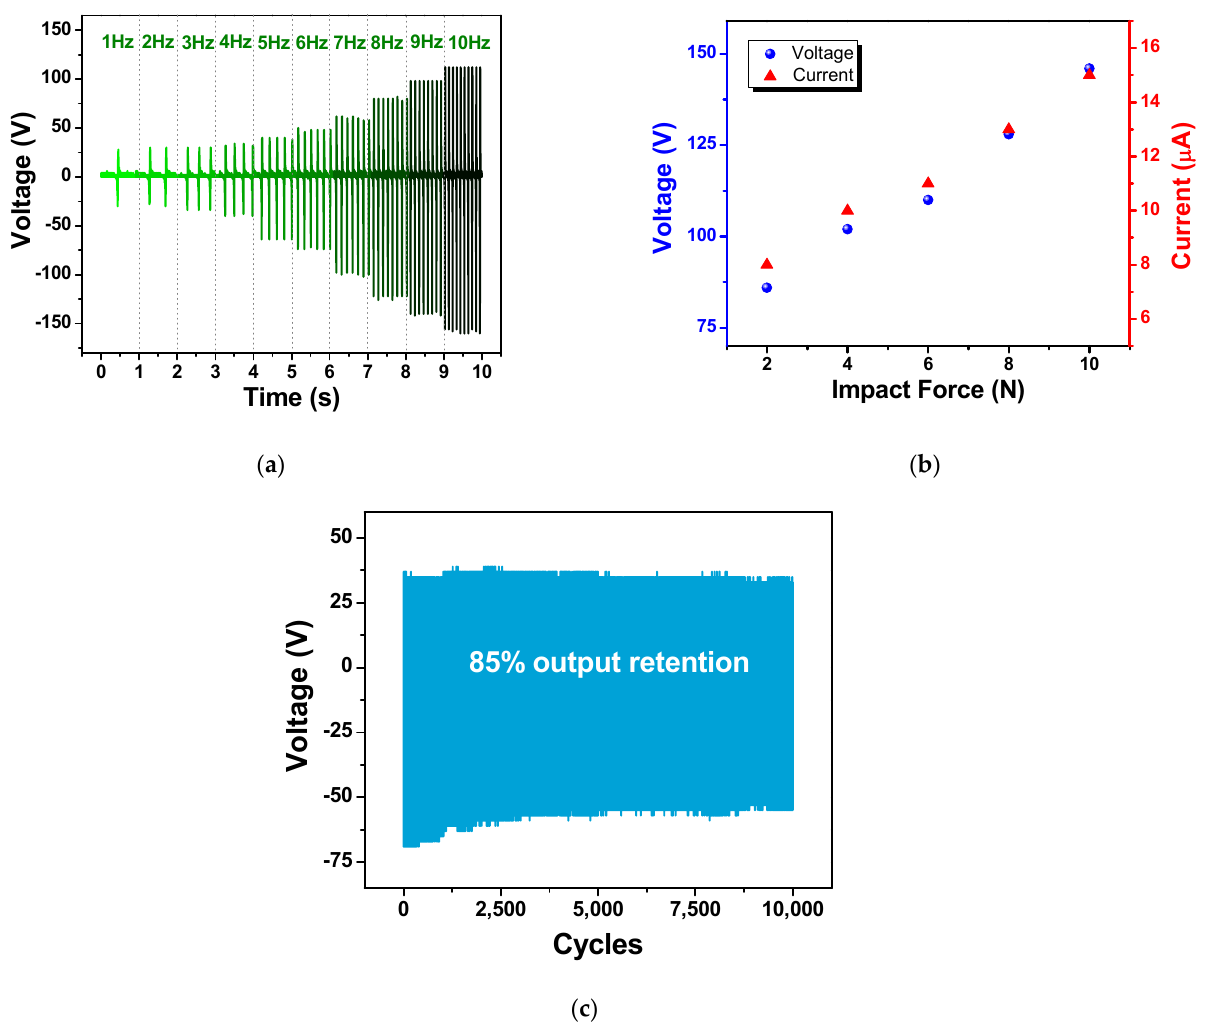
Figure 6. The dependence of TENG outputs on ( a ) working frequencies and ( b ) impact force of the CFP_F3 TENG; ( c ) output voltage retention of the TENG over the repeated operation of 10,000 cy ‐ cles.